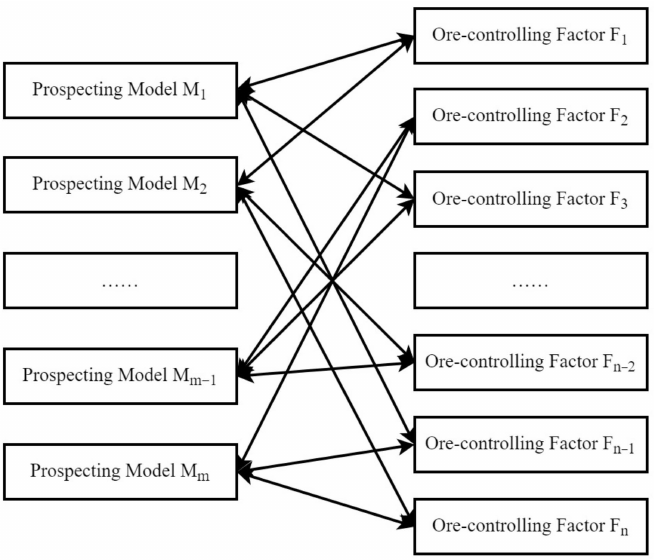
Figure 5. The many-to-many relationship between prospecting model and ore-controlling factors (adapted with permission from Ref. [21]. 2017, Wu, Y.L).